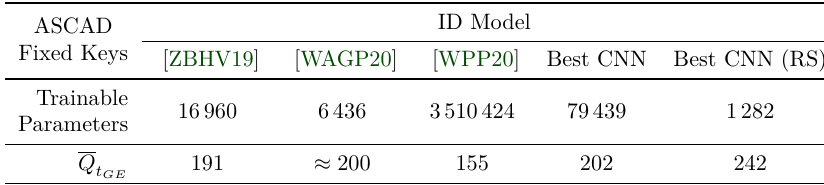
Table 3: Comparison of the top generated CNNs for the ASCAD with a fixed key ID leakage model experiments with the current